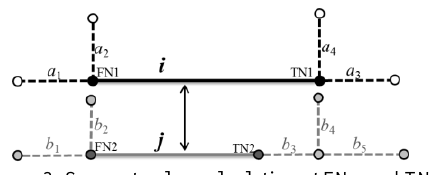
Figure 3. Support value calculation at FNs and